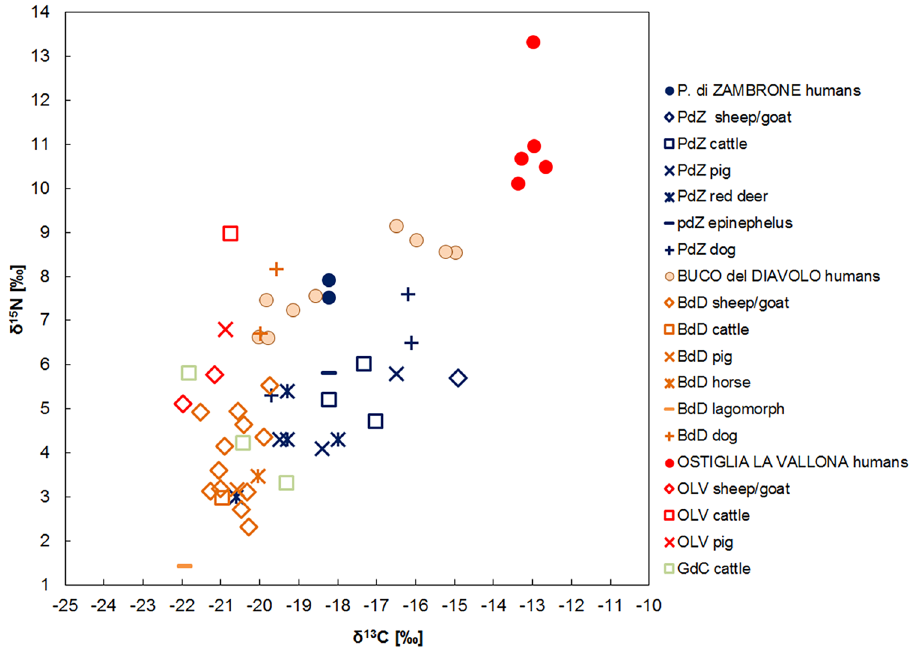
Figure 4. The δ 15 N and δ 13 C human and animal values for the Italian Recent and Final Bronze Age